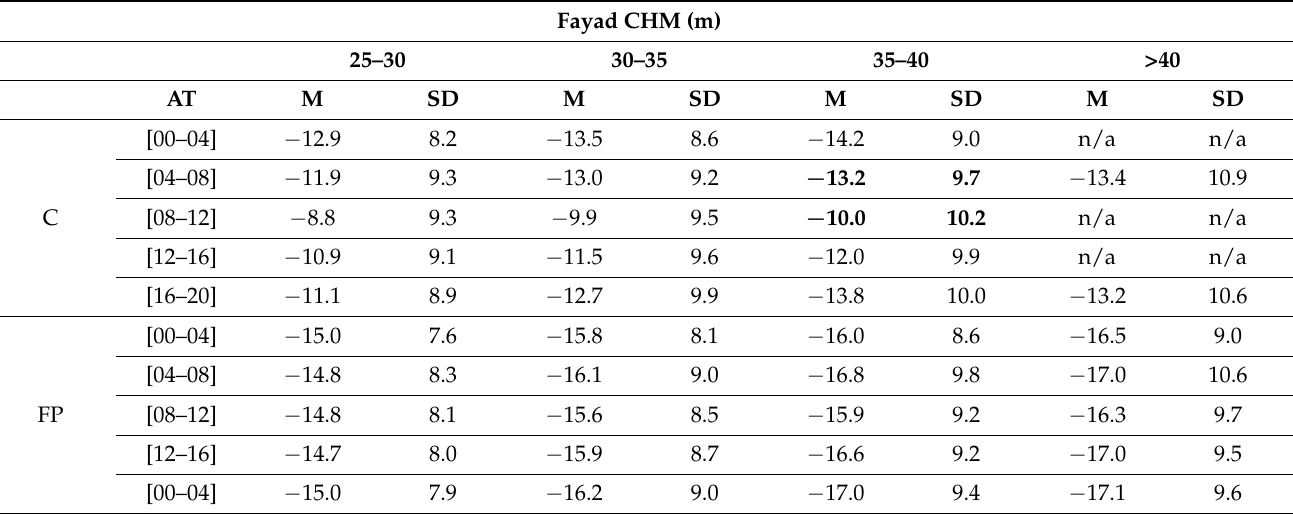
Table A5. Mean (M) and standard deviation (SD) in meters of the elevation difference between ELM and SRTM, grouped by different acquisition times and Fayad CHM. (C) and (FP) correspond to the ELM values from GEDI’s coverage and full-power lasers, respectively.